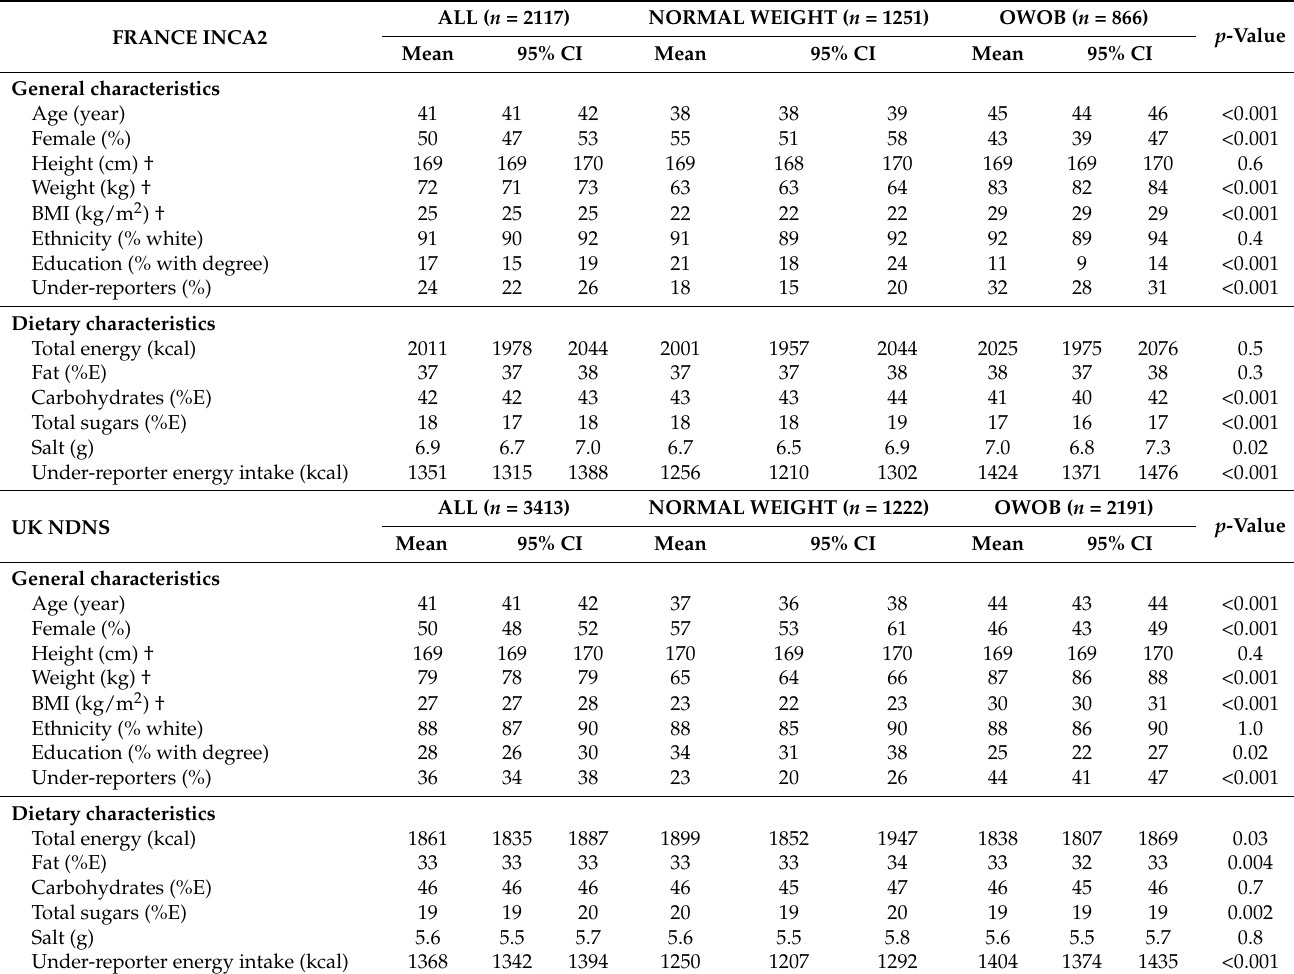
Table 1. General and dietary characteristics of all adults aged 19–64 y * in the French INCA2 and UK NDNS (Y1–6) dietary